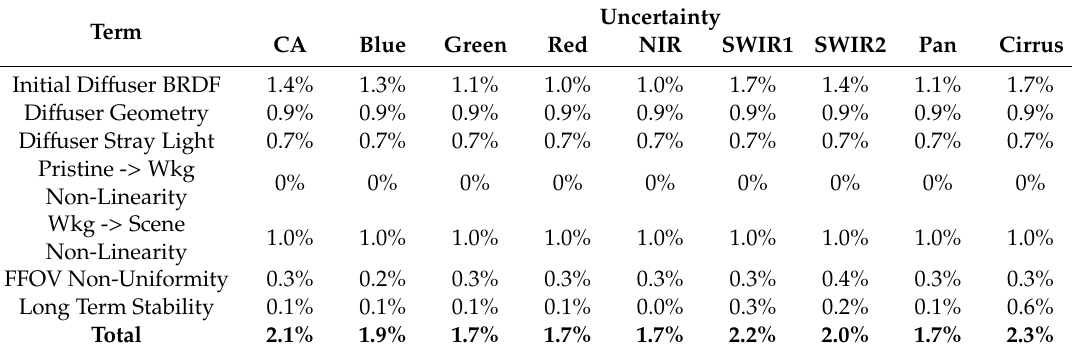
Table 2. Prelaunch reflectance-based calibration uncertainty for Landsat 8 OLI.